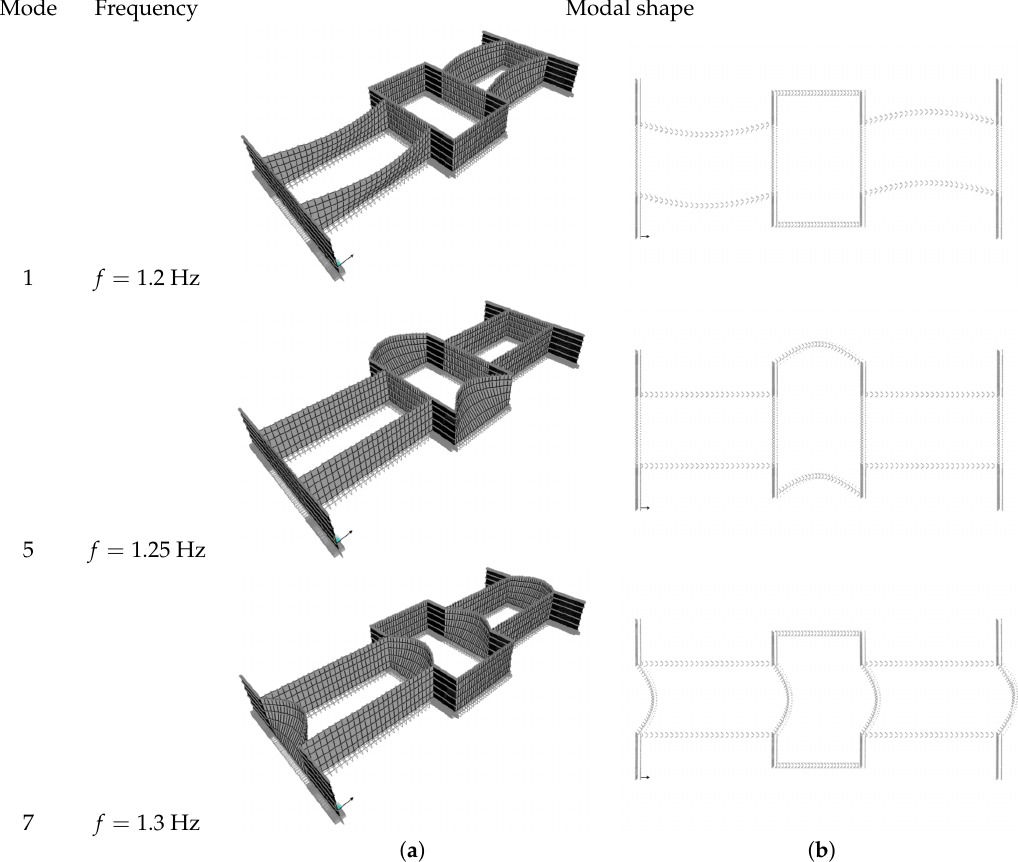
Figure 21. Natural modes of the global LTW homogenized model. Modal shape in the ( a ) 3D space; ( b ) x − z